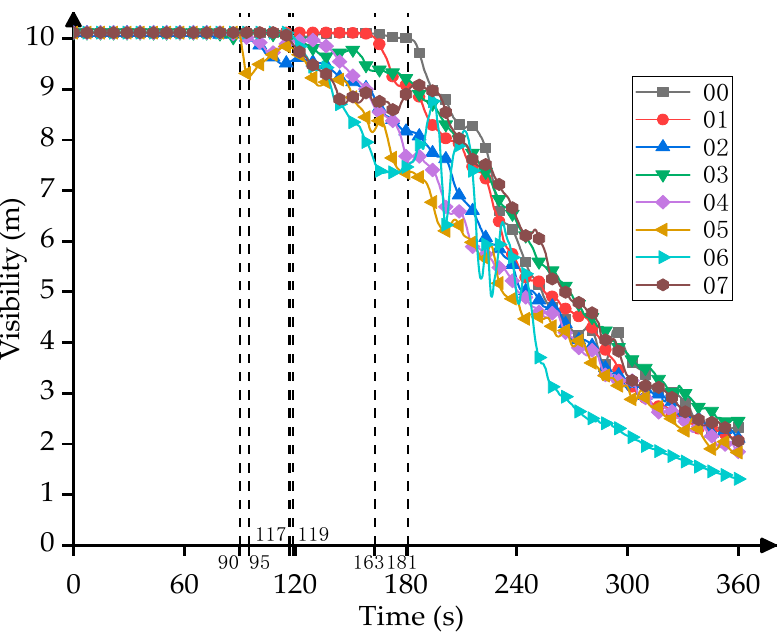
Figure 14. Visibility analysis in the fire in the middle of the platform.